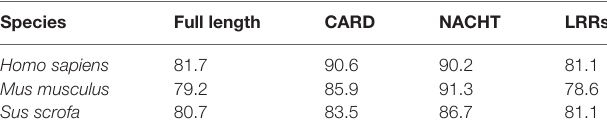
TaBle 2 | Amino acid identity (%) of rNOD1 and its domains (CARD, NACHT, and LRRs) compared to other species. species Full length carD